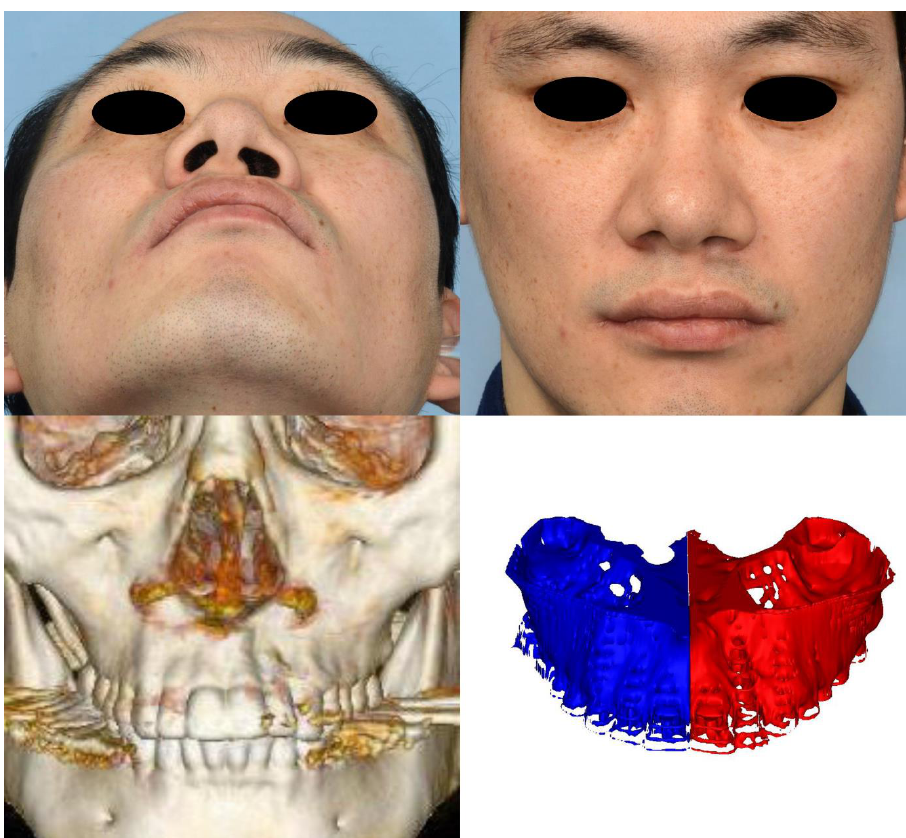
Figure 8. Case 3. A 39-year-old male patient. ( upper ) Worm’s-eye view and frontal view. The clinical phenotypes of the patient were associated with the general characteristics of microform cleft lip. The nostril is more inclined, the distance from the columella to the notch is wide, and the thickness of the dry vermilion is smaller on the cleft side. ( lower, left ) Anterior view of 3D-reconstructed computed tomography scan and 3D-reconstructed image of the alveolar bone using Mimics software. Deviation of the axis is not obvious; however, depression of the anterior nasal crest is well demonstrated. ( lower, right ) The alveolar volume was 9155.08 mm 3 on the cleft side and 8249.11 mm 3 on the other side. The volume was larger on the cleft side, with a difference of 905.97 mm 3 .